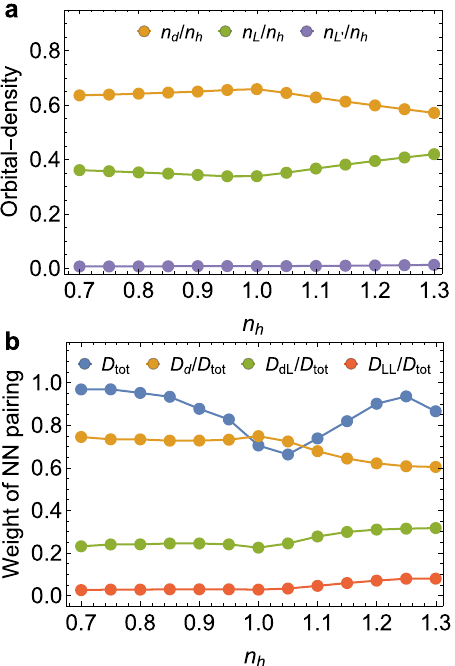
Fig. 4 Orbital-resolved density and pair components. a Ratios of the orbital-resolved hole densities to the total density n h . b Weights of different orbital components of the nearest-neighbor pairs, as de fi ned in Fig. 1, and their total weight. All results were obtained on a 4 × 4 cluster at β = 16 eV − 1